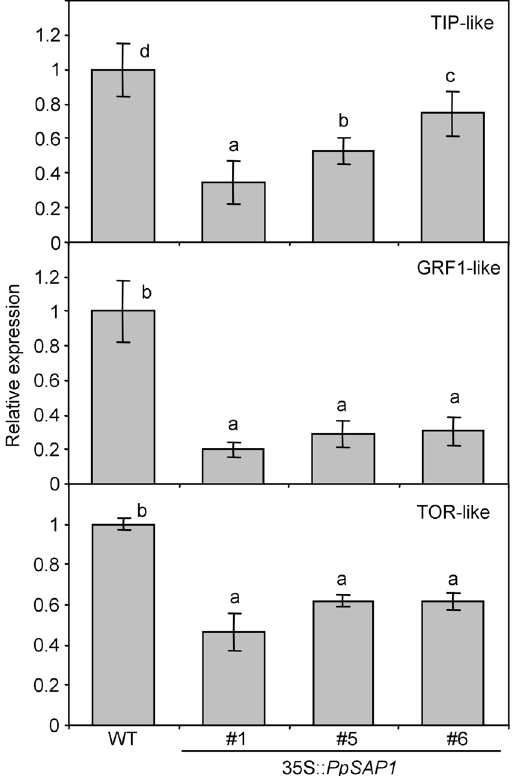
Figure 9. Genes differentially expressed in PpSAP1 overexpressing lines. The relative expression of TIP -like, GRF1 -like and TOR -like genes in wild type (WT) and 35S:: PpSAP1 lines #1, #5 and #6 is shown. An expression value of one is assigned to the WT. Data are means from three biological samples with two technical replicates each, with error bars representing standard deviation. Different letters ( a – d ) indicate significant difference between samples with a confidence level of